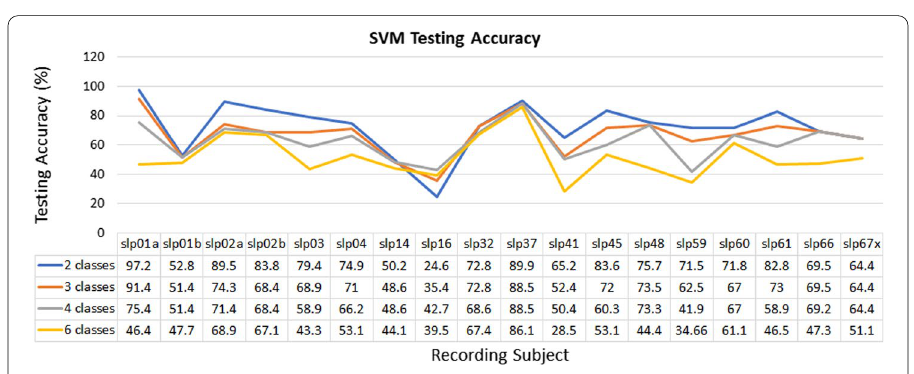
Fig. 4 The testing accuracy of SVM algorithm in 4 sets of